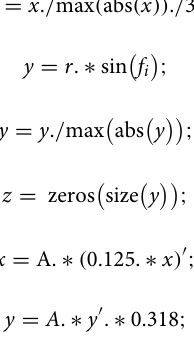
used the perimeter of the Euclidean structure as initial values, with values of the square antenna side ( L An = W An ), transmission line width ( W GP )and the length ( L S ) and width ( W S ) of the slit on the ground plane (LS). In work were use the dimension of the square monopole antenna by the Eq. (1). The elliptical leaf, Fig. 1a, for dimensions of length ( L l ) and width ( W An ) of the leaf, were generated by Gielis formula in the MATLAB software version 2015(b) with the parameters of m = 2, n 1 = 400, n 2 = 1200, n 3 = 1200, a = 1, b = 1. The values of x , y , and z axis are adjusted by the A = 36.16, circle angle step of H = 360, the range of f i = [0:π/(H):2π]. The code MATLAB version 2015(b) used in the elliptical leaf is: